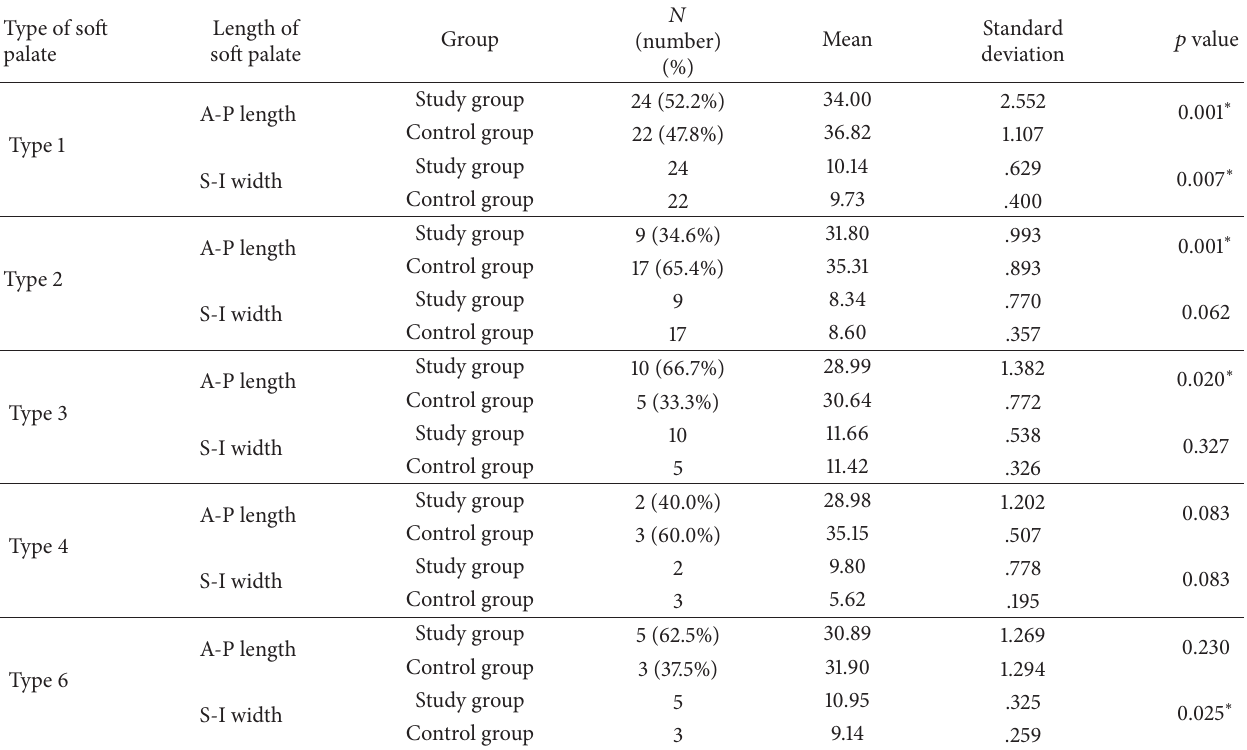
Table 1: Comparison of anteroposterior (A-P) length and superoinferior (S-I) width in the study and control group using Kruskal Wallis test. Type of soft